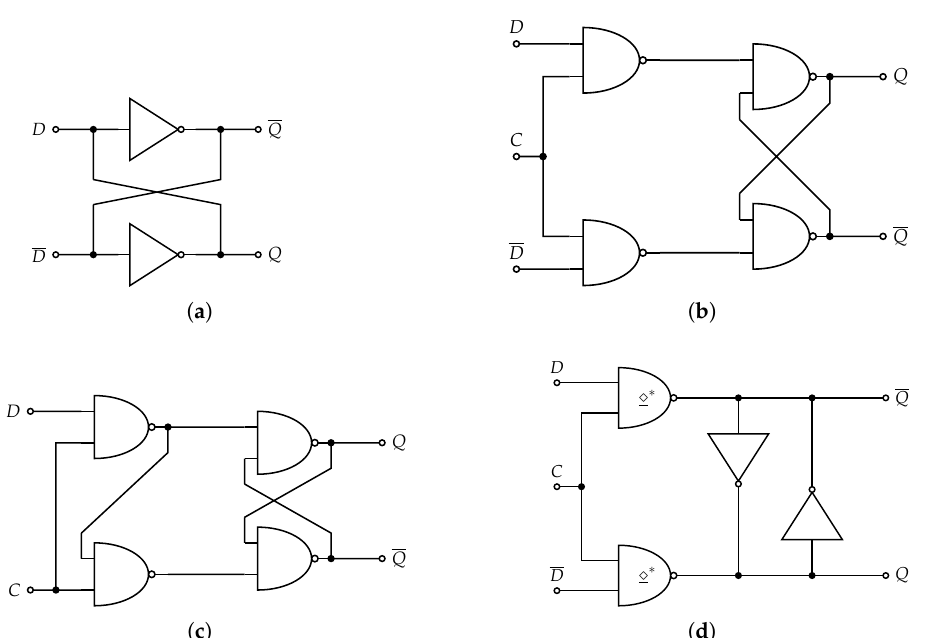
Figure 7. Basic level-controlled memory blocks (latches). ( a ) Cross-coupled inverters. ( b ) 4-NAND differential-input active-high D latch. ( c ) 4-NAND single-input active-high D latch. ( d ) Simplified differential-input active-high D latch with pseudo-open collector